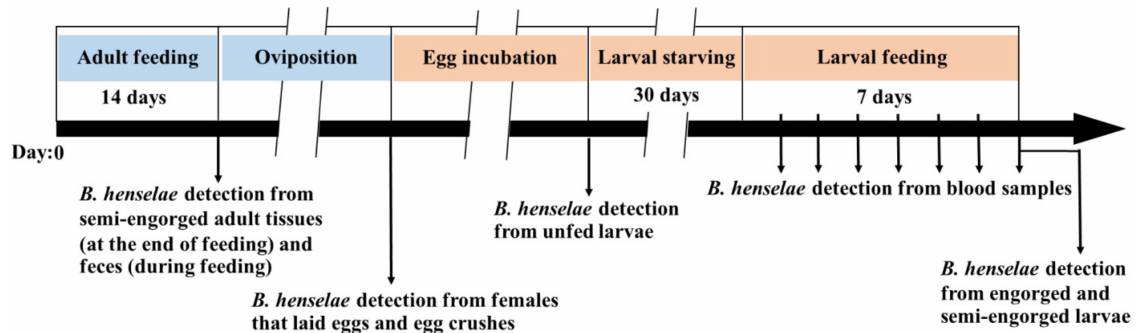
Figure 1. Experimental framework of R. sanguineus s.l. adult ticks infected by B. henselae -infected blood and bacteria DNA detection in tick and blood